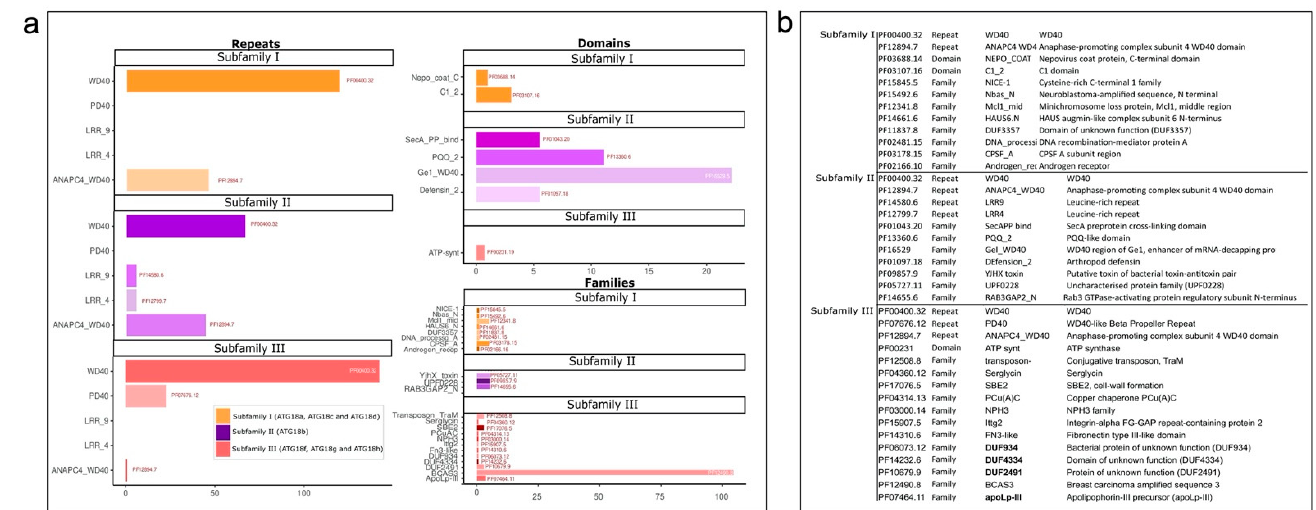
Figure 9. Repeats, domains and families of ATG18b sub ‐ families. ( a ) The ATG18 protein functions were determined using Pfam, and the proteins were divided into subfamilies: Subfamily I (yellow), subfamily II (purple) and subfamily III (red). ( b ) Pfam identifiers and their annotations.